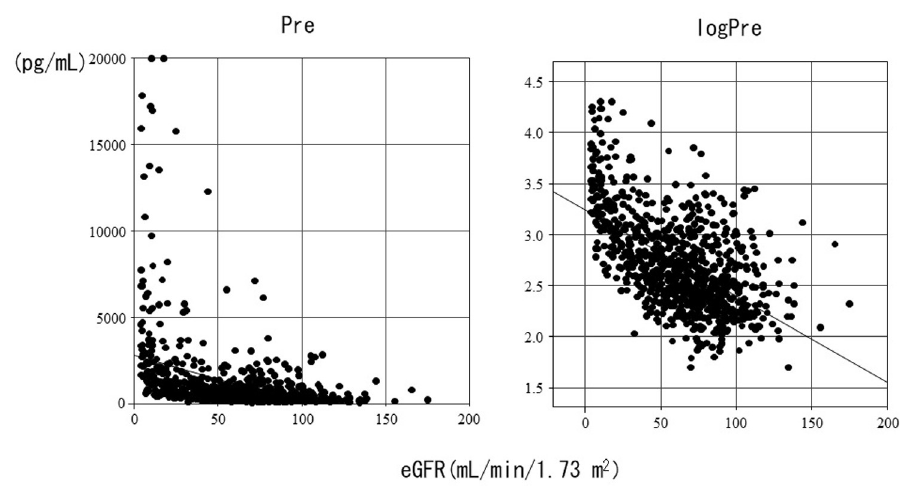
Fig 1. Correlation between Pre and log-transformed Pre values and eGFRs in all subjects. eGFR: estimated glomerular filtration rate; Pre: presepsin value. logPre: log-transformed presepsin value. Spearman’s correlation coefficient = − 0.55, p < 0.01.